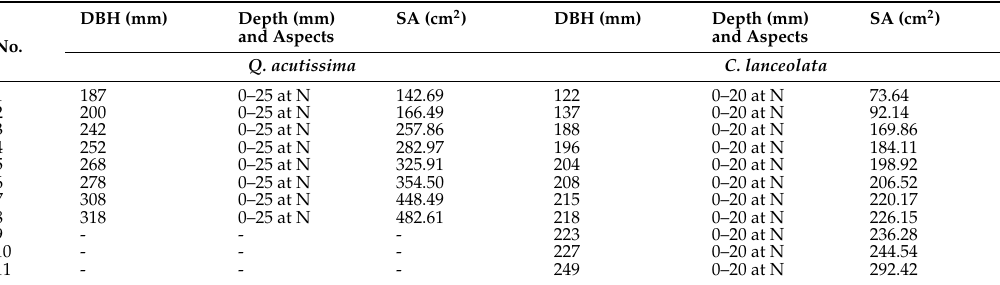
Table 1. Basic parameters of the samples in the two forests.